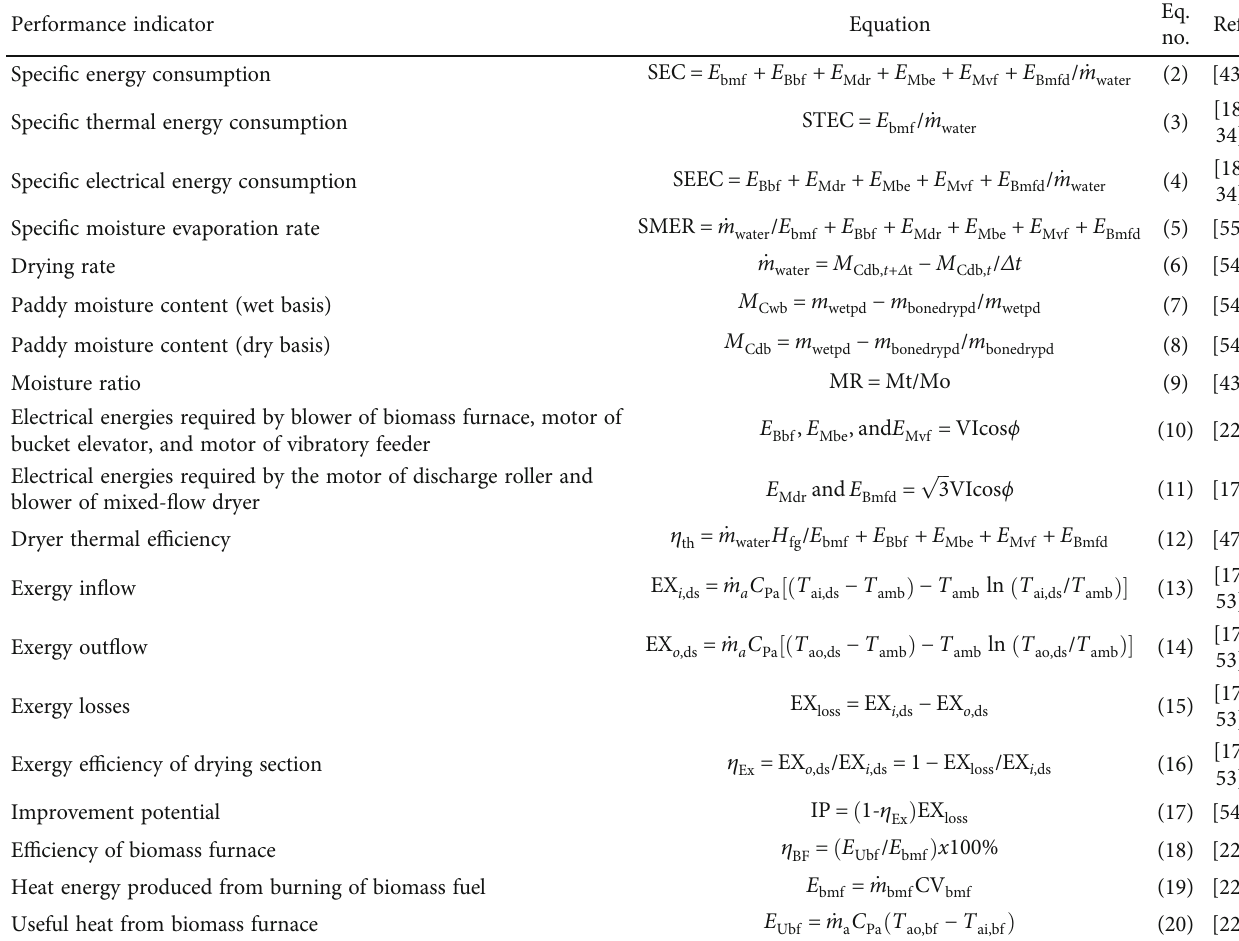
Table 2: Equations used to determine the performance of the PSBA-RMFD.